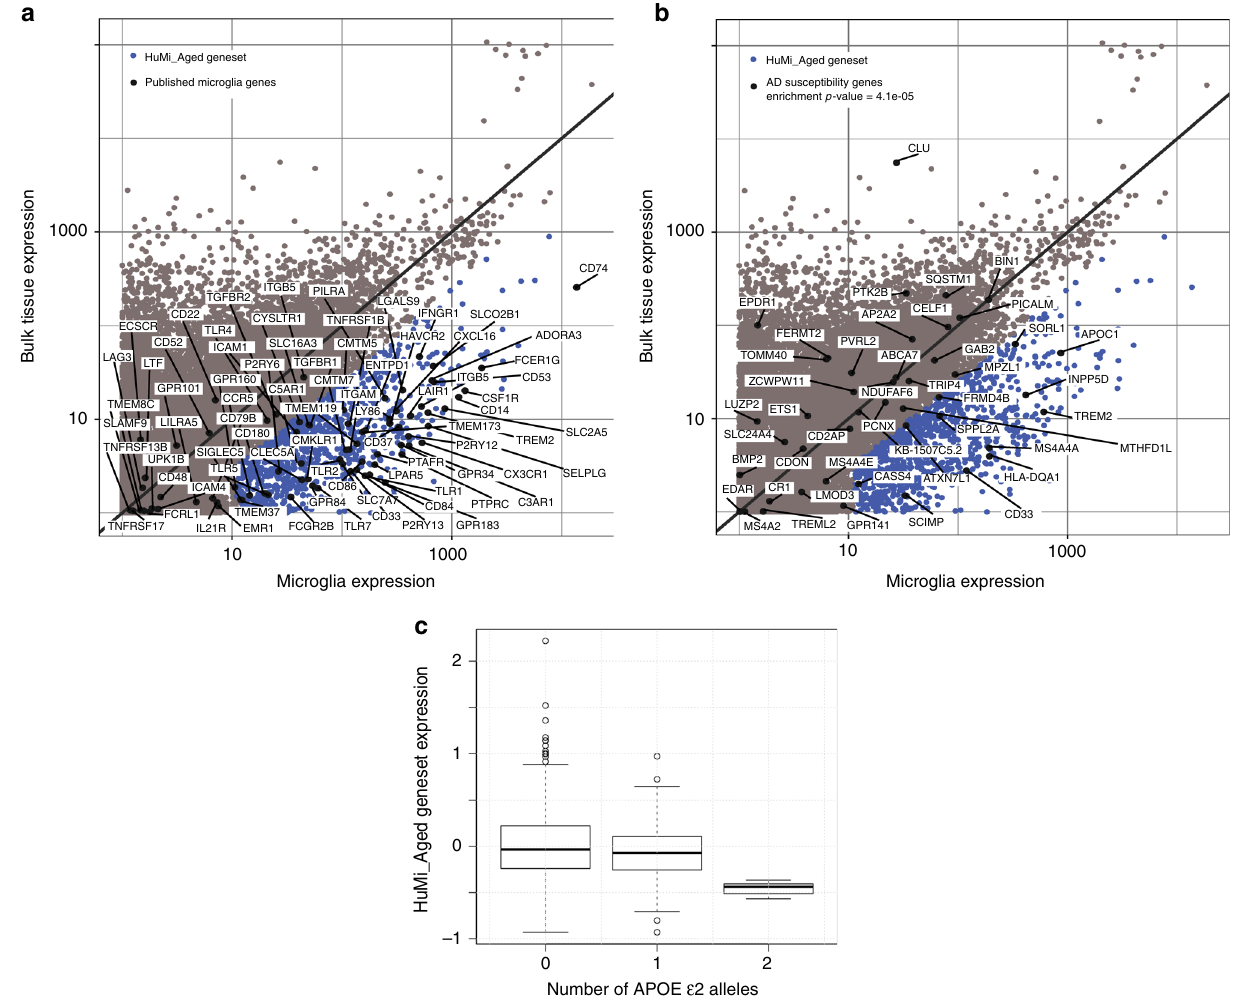
Fig. 1 The HuMi_Aged and its relationship to genetic risk of AD. a Scatter plot depicting the distribution of gene expression values between the bulk DLPFC ( N = 540) and the isolated microglia ( N = 10). Each dot represents a gene. The X and the Y axes show normalized expression values. One thousand fi fty four genes have been identi fi ed to be preferentially expressed by microglia (based on the differences in gene expression between the isolated microglia and the bulk cortical tissue, FC > 4) in the aged human brain (dark blue dots). This set of genes has been coined the HuMi_Aged gene set. The HuMi_Aged gene set contained many of the previously established microglia markers in the brain (black dots), such as CD74 , CX3CR1 , P2RY12 , TREM2 or GPR34 . b Scatter plot showing the distribution of AD risk genes (black dots) in the transcriptomic universe de fi ned by the bulk cortical and the microglial RNA- Sequencing datasets. Each dot represents a gene. The X and the Y axes show normalized expression values. By using an overrepresentation test, the HuMi_Aged gene set (blue dots) was found to be signi fi cantly enriched in Alzheimer ’ s disease risk genes (black dots; enrichment p- value = 4.1e-05). The HuMi_Aged included AD risk genes, such as CD33 , TREM2 , INPP5D , APOC1 or SCIMP , while other AD risk genes (e.g., BIN1 or TREML2 ) were found to be not speci fi c to microglia in the aged brain. c APOE ε 2 was associated with reduced expression of HuMi_Aged in the bulk tissue level data ( N = 540).